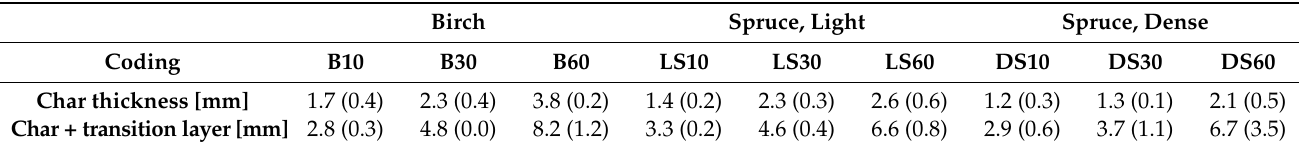
Table 2. Char and transition layer thicknesses are measured from cut-outs of several samples, standard deviation in parenthesis. Birch Spruce,